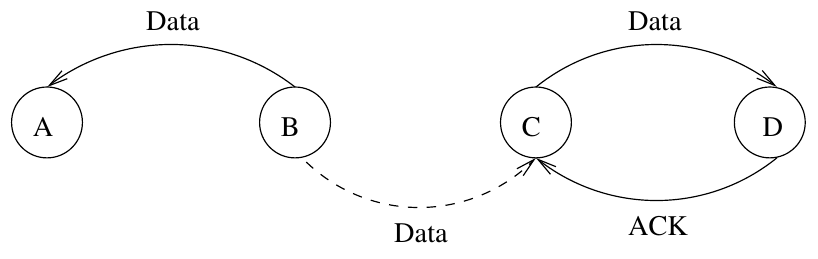
Figure 2. 3-hop neighborhood interference in channel allocation with